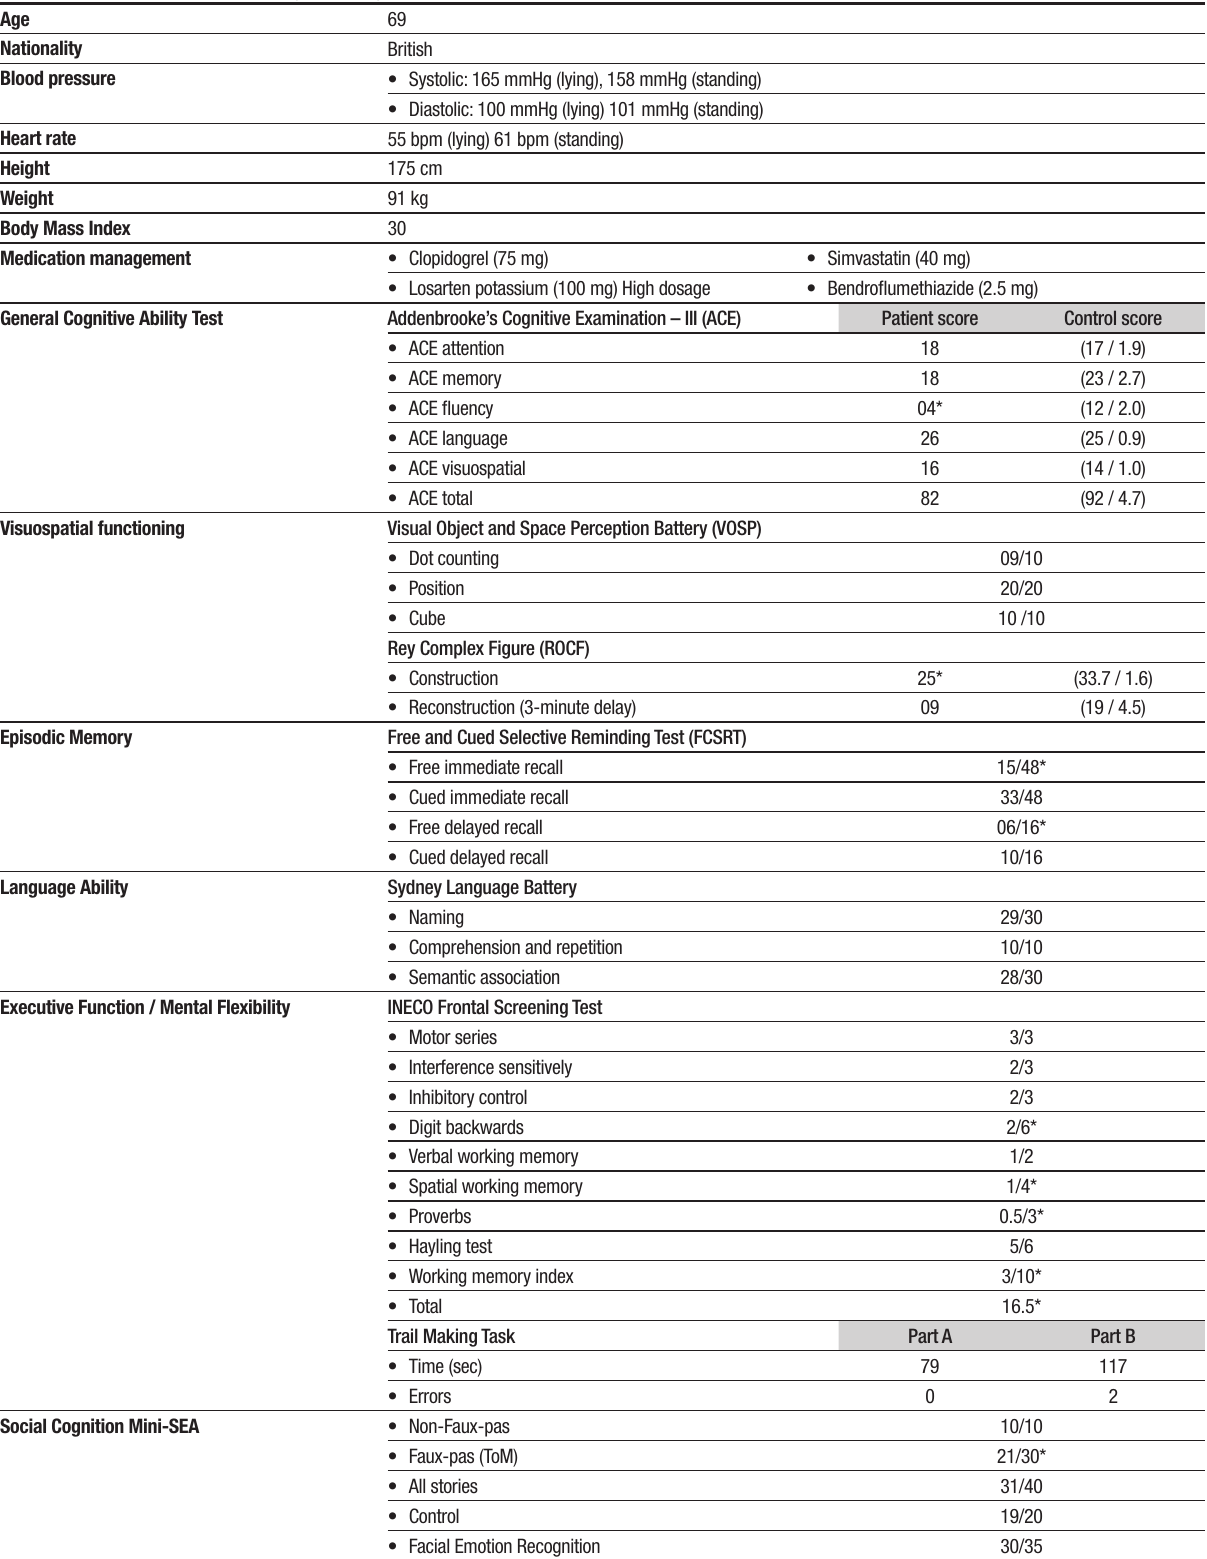
Table 1. Physical and neuropsychological